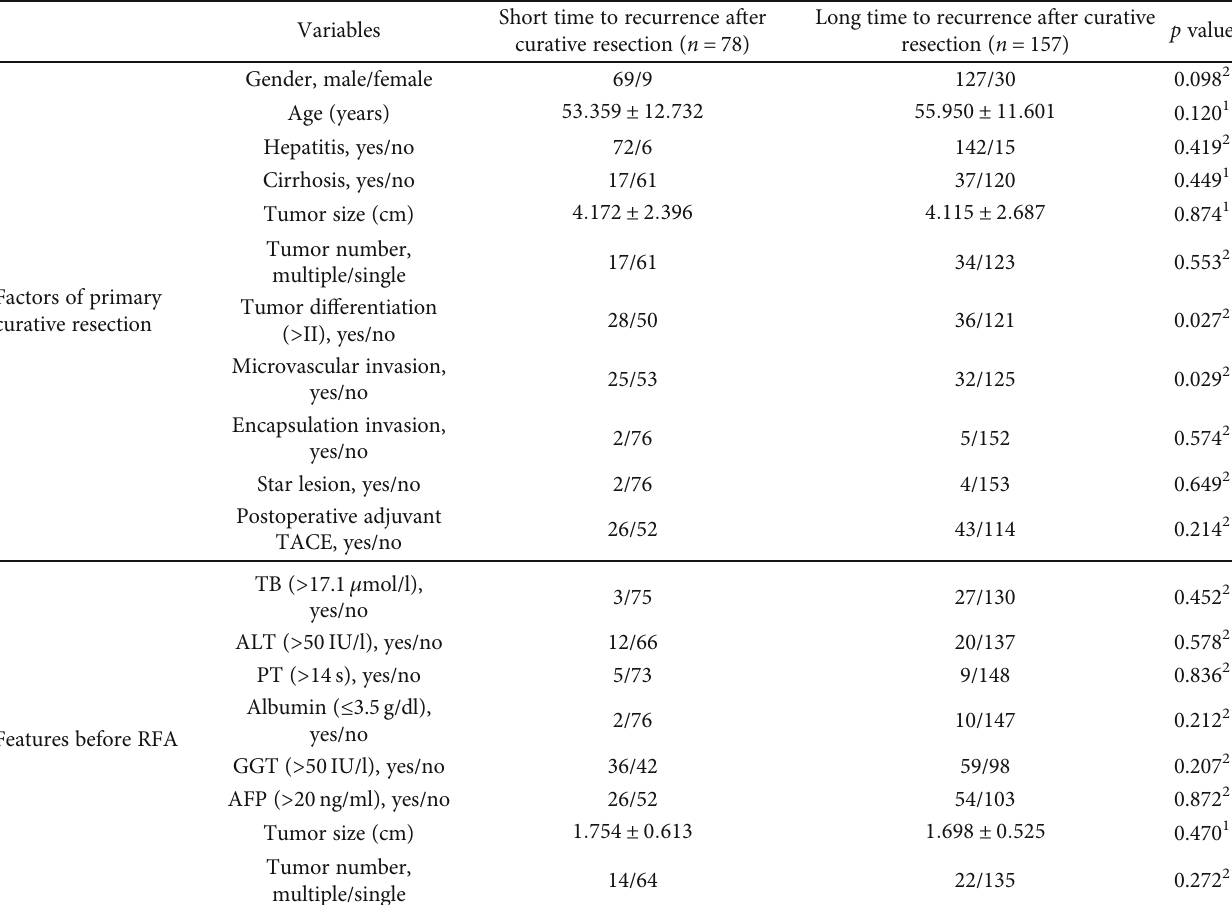
Table 5: Baseline characteristics between the short time to recurrence after curative resection group and the long time to recurrence after curative resection